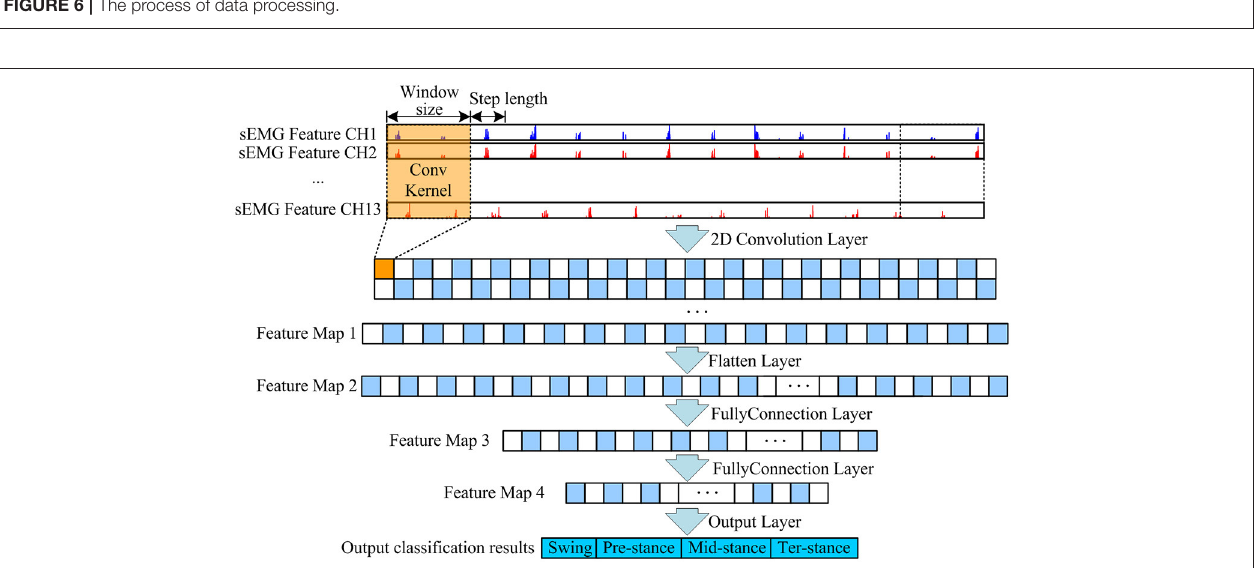
FIGURE 6 | The process of data processing.